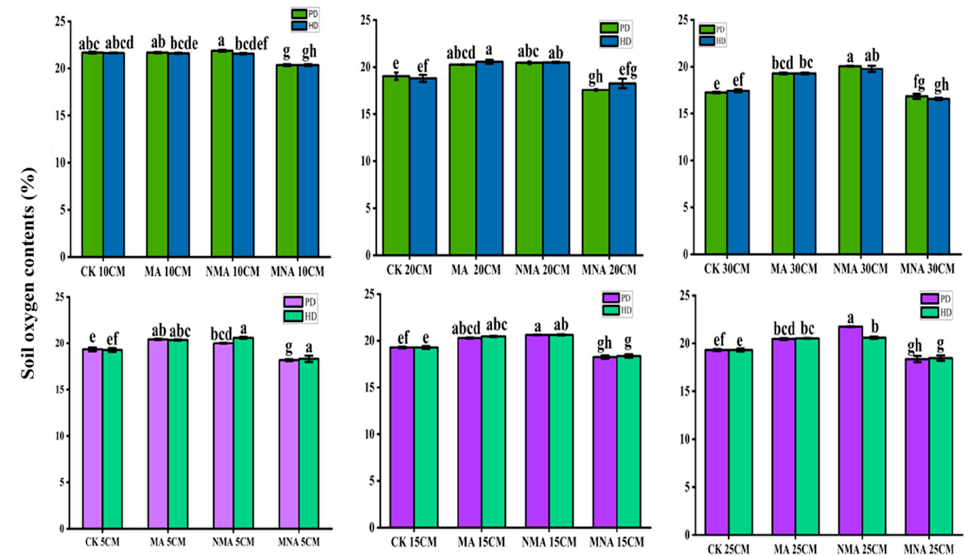
Figure 2. Effects of soil depth ( top row ) and distance from plant trunk ( bottom row ) on soil oxygen content. The bars are the standard error of the replications while the different letters on the bars indicate significant differences at p < 0.05.